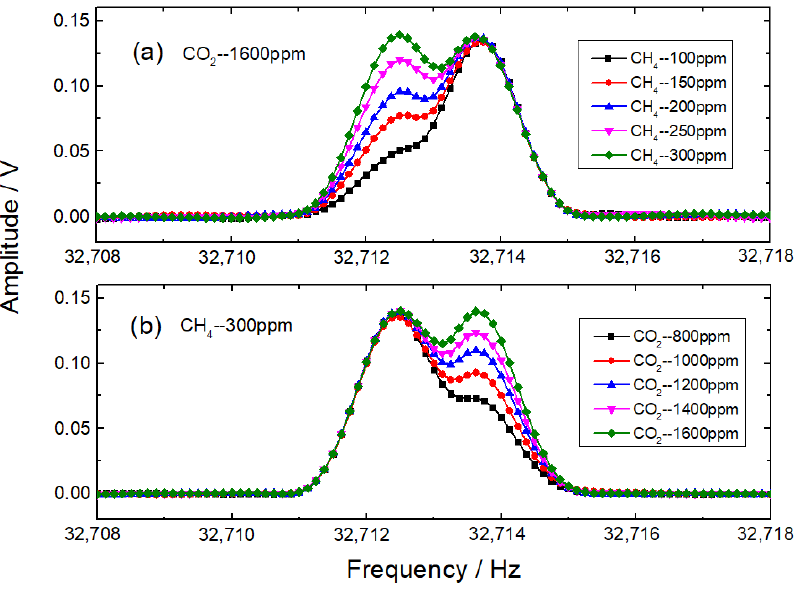
Figure 5. Frequency-domain 2 f signals of different gas mixtures. ( a ) First group; ( b ) second group. Standard gas samples of 200 ppm CH 4 and 1200 ppm CO 2 were injected into the photoacoustic cell successively, with a flow rate of 50 mL/min. As depicted in Figure 6a, the frequency-domain 2 f signals of CH 4 and CO 2 are measured individually and are utilized as the basics in the application of multiple linear regressions. Figure 6b demonstrates an excellent fitting result of a gas mixture of 300 ppm CH 4 and 800 ppm CO 2 , which is confirmed by the negligible <1.5% difference shown in Figure 6c.